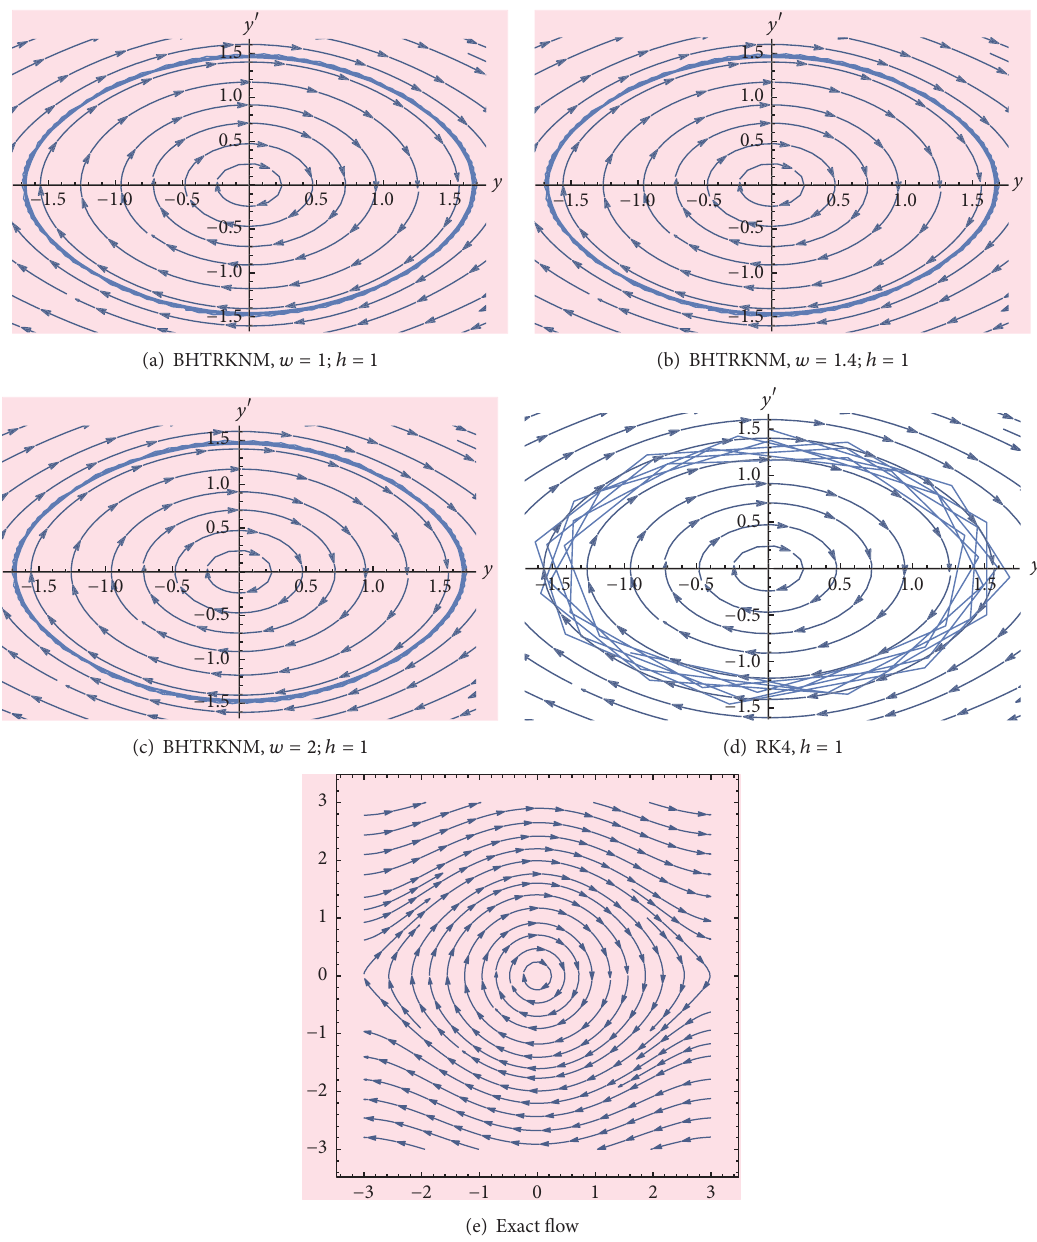
Figure 8: The pendulum problem: phase diagrams for BHTRKNM with 𝑤 = 1, 1.4, 2 are presented in (a), (b), and (c), respectively. (d) illustrates a distortion in the flow for the RK4, while (e) shows exact flow of the pendulum problem. In the diagrams, 𝑦 = 𝑞 ; 𝑦 󸀠 = 𝑞 󸀠